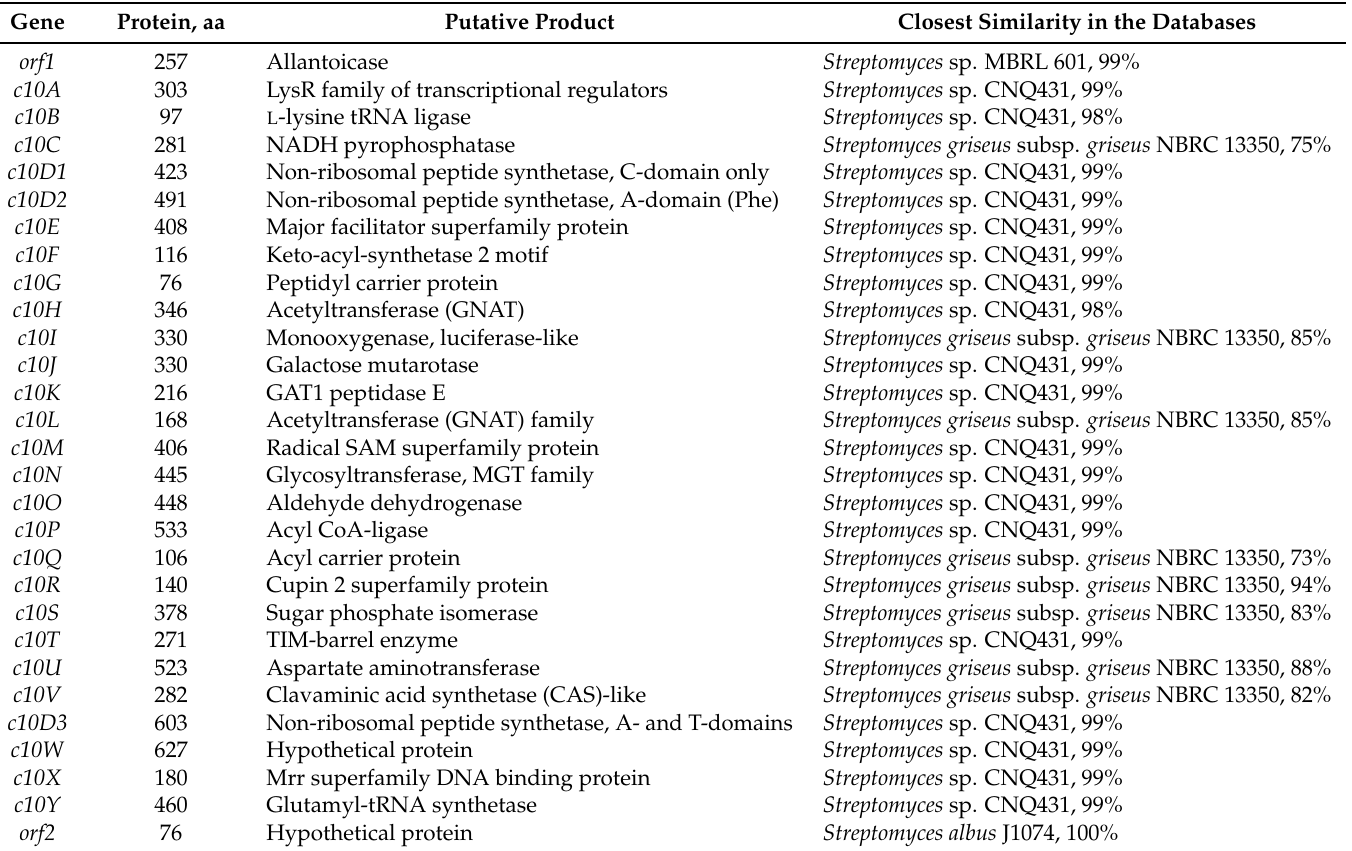
Table 1. Features of the C10 cryptic biosynthetic gene cluster in S. albus